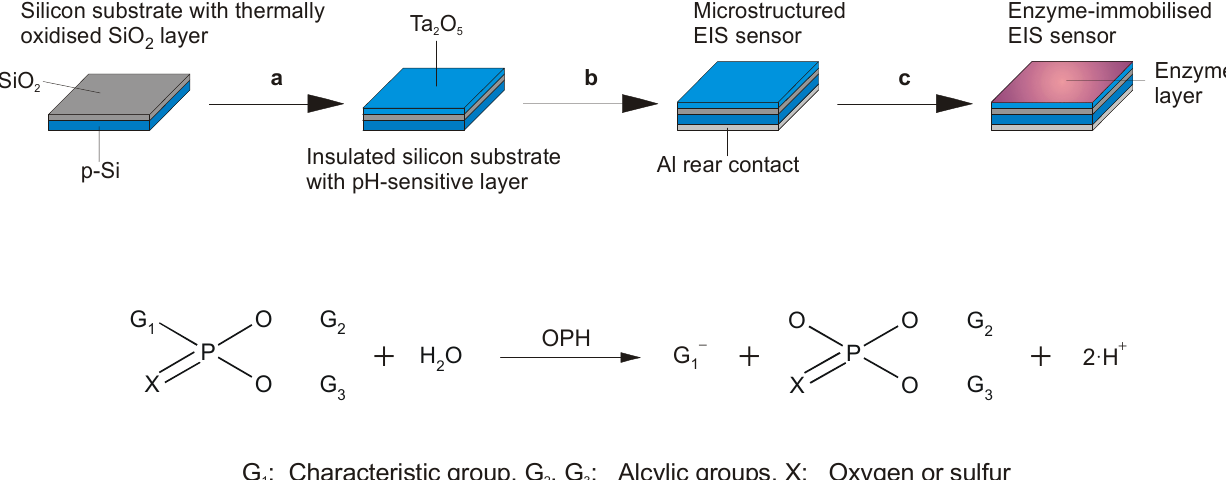
Figure 1. Schematic of fabrication steps (a-c) of the capacitive EIS biosensor (upper part), and hydrolytical reaction of the enzyme OPH releasing H + ions that can be detected by means of the pH-sensitive transducer surface (lower part).